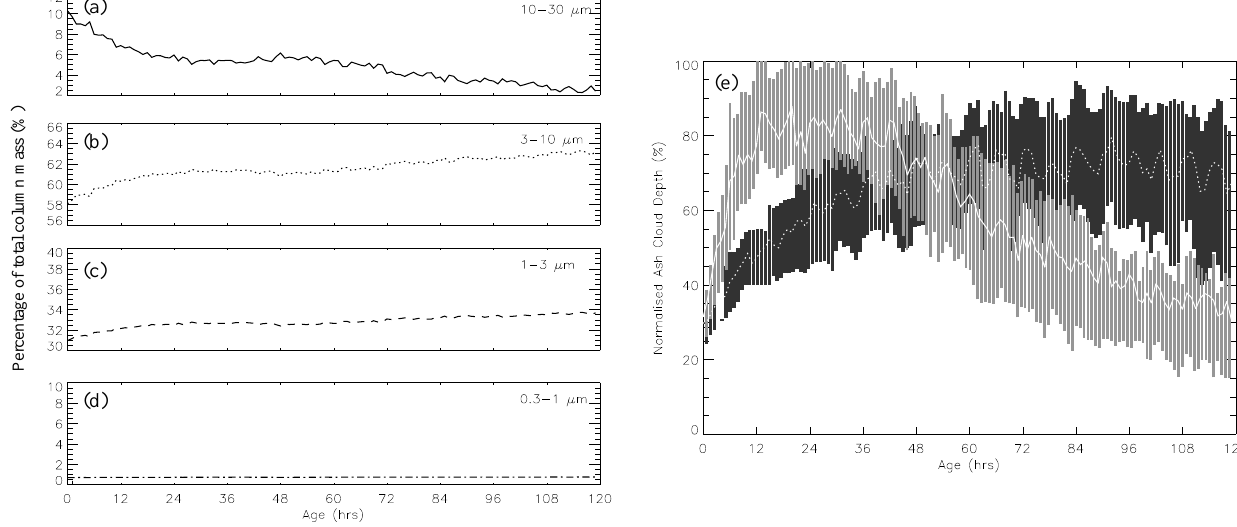
Fig. 12. (a) Mean percentage of total column-integrated mass carried by (a) 10–30µm diameter particles, (b) 3–10µm particles, (c) 1–3µm diameter particles and (d) 0.3–1µm diameter particles. (e) Mean and 25–75th percentile of normalised ash cloud depth for 10–30µm diameter particles (solid line, light grey shading) and 1–3µm diameter particles (dotted line, dark grey shading). particle measuring probes which measured the concentration of volcanic ash carried by particles of varying sizes.